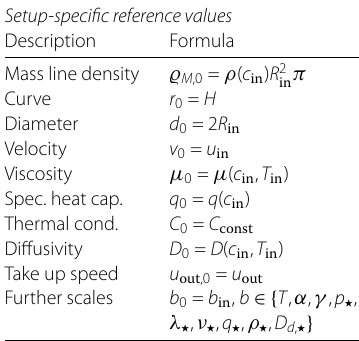
setup-specific reference values Physicalparameters Description Symbol Value